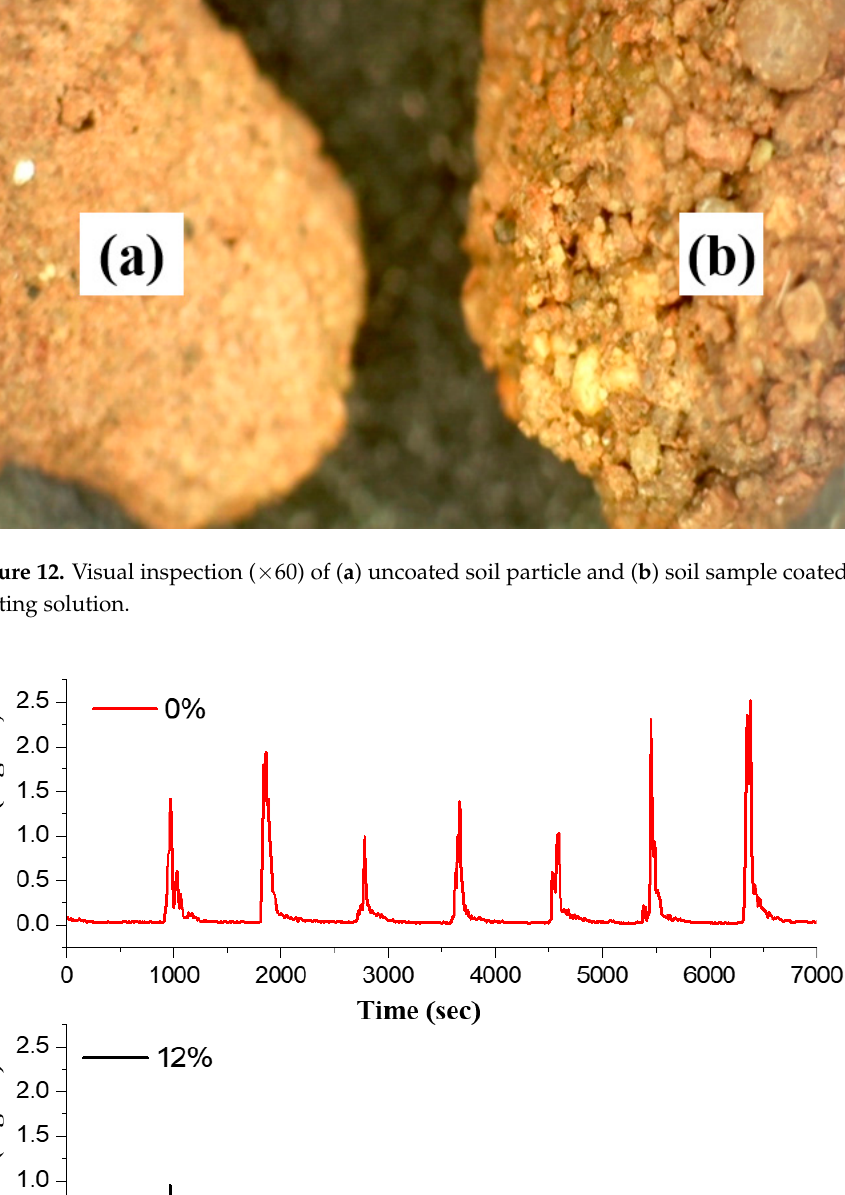
Figure 11. PM 2.5 dust generation for soil samples.